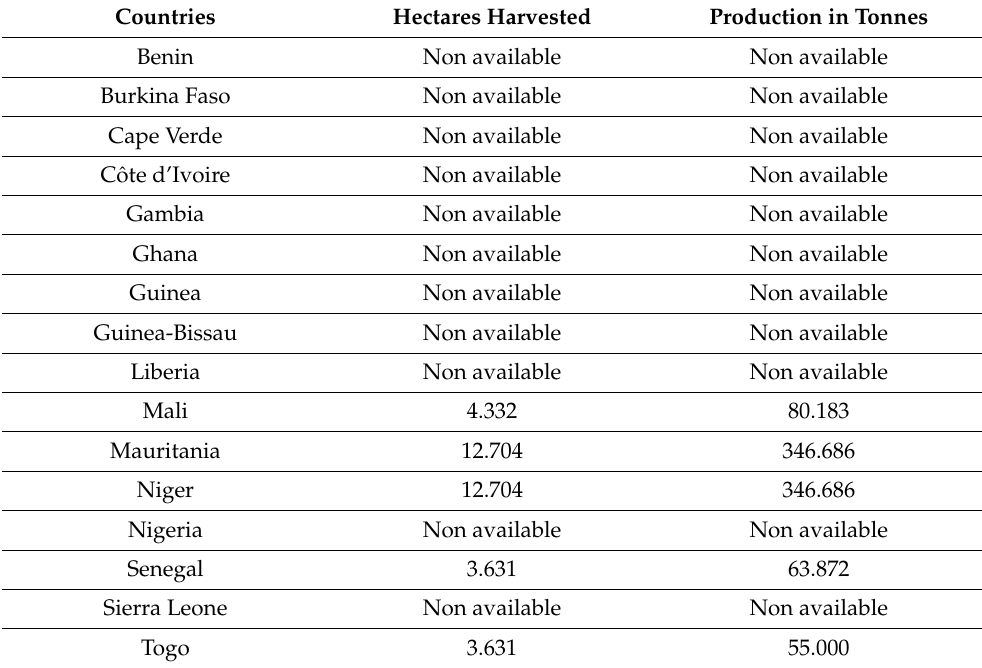
Table 1. Production of cabbages and other Brassicaceae per ECOWAS country (FAOSTAT, 2018) (consulted 06/04/2020). Countries Hectares Harvested Production in Tonnes Benin Non available Non available Burkina Faso Non available Non available Cape Verde Non available Non available C ô te d’Ivoire Non available Non available Gambia Non available Non available Ghana Non available Non available Guinea Non available Non available Guinea-Bissau Non available Non available Liberia Non available Non available Mali 4.332 80.183 Mauritania 12.704 346.686 Niger 12.704 346.686 Nigeria Non available Non available Senegal 3.631 63.872 Sierra Leone Non available Non available Togo 3.631